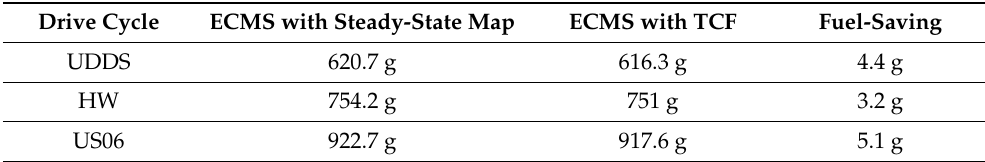
Table 5. Total fuel consumption under ECMS with and without